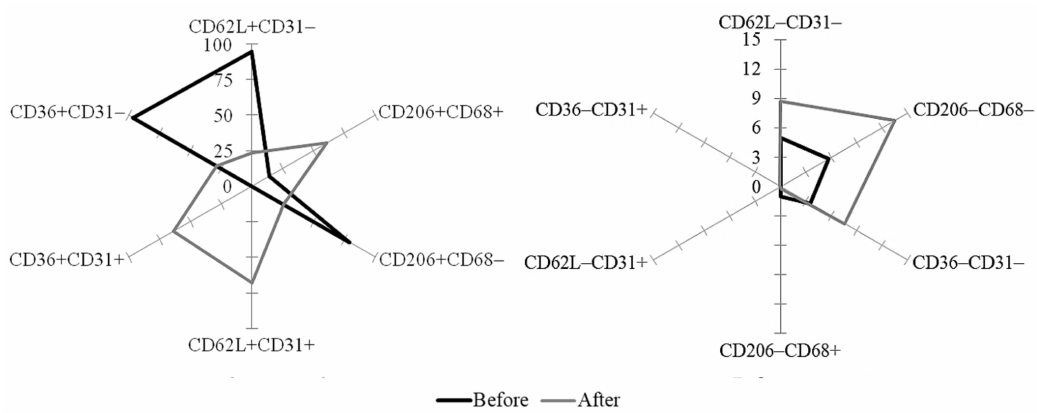
Figure 2. The ratio of CDphenotypes of MNs isolated from patients’ blood before stenting (Before) and after stenting (After). The relative abundance of CD phenotypes is expressed as a percentage. The abundance of 3 CD phenotypes, CD36 − CD31 + , CD62 − CD31 + , CD206 − CD68 + , before stenting and after stenting did not di ff er significantly. For each of the remaining 9 CD phenotypes, were revealed statistically reliable di ff erences in Before and After variants ( p < 0.05).